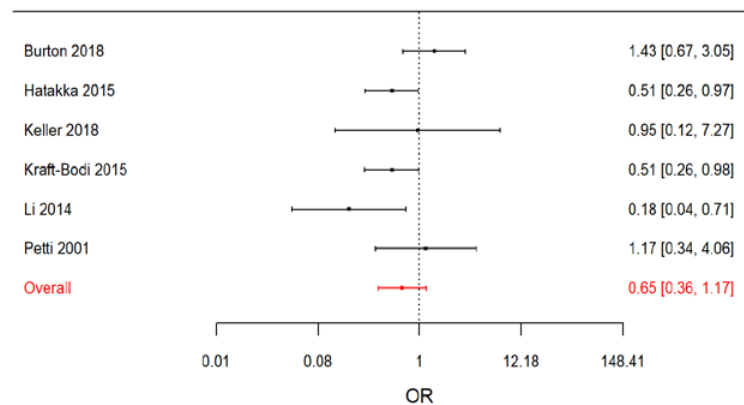
Figure 6. Forest plot from the Bayesian random-effects meta-analysis of the randomized controlled studies on non-denture wearers.